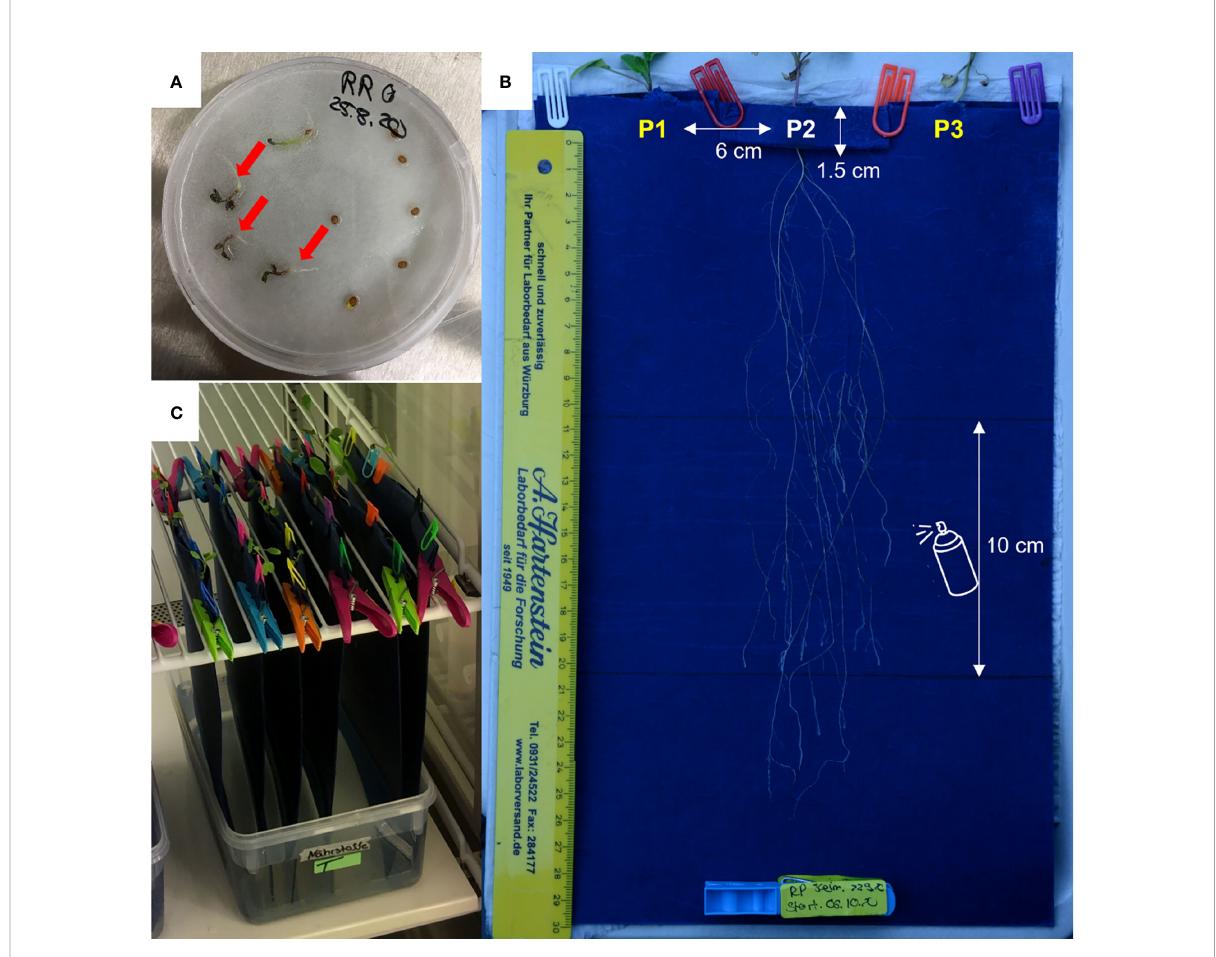
FIGURE 4 Experimental setup to mimic root growth in surrogate media for soil types and simultaneous, semi-automated root growth analysis. (A) Seedlings of R. raphanistrum and R. pugioniformis were germinated in petri dishes on moistened fi lter paper, until the radicles were clearly visible and cotyledons were fully developed (red arrow). (B) The seedlings were transferred to the root growth experimental set up. Three pockets of 1.5 cm depth were folded on the upper edge, with a hole at the bottom, to insert the radicle through. The distance between the seedlings was 6 cm. Two seedlings were placed on one side of the paper near the edges, and a third seedling was placed in the middle on another side (visible in the fi gure). The middle section of 10 cm was sprayed with soil surrogate every other day. (C) All the experimental setup were hung vertically in a climate chamber, with the lower edge touching a reservoir of distilled water for continuous capillary water uptake. Altogether 27 seedlings per species were analysed for root architecture (3 soil surrogates X 3 seedlings X 3